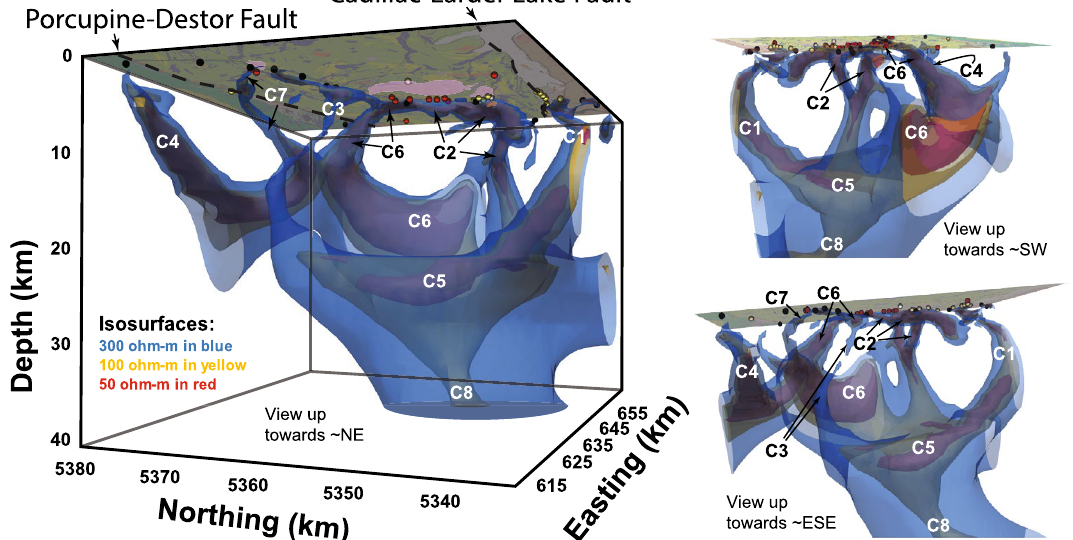
Figure 4. 3D MT model with surface geology (see Fig. 1). C1-8 indicate significant low-resistivity features (see text). The two panels on the right are different perspectives of the same 3D model to help visualize the connectivity of many of the low-resistivity features. This Figure was compiled in Adobe Illustrator (≥ v. CC2018 22.0.0) with individual panels created in the open-source ParaView application: https:// www. parav iew.